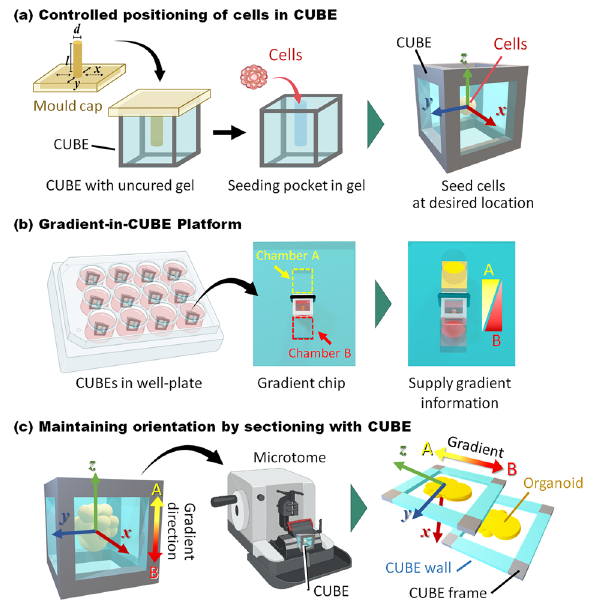
Fig. 1 Work fl ow from gradient culture to sectioning for imaging. The concept for this work was to utilise the CUBE culture device to a fi rstly control the seeding position of cells at the desired location, b then transfer the CUBE to a Gradient-in-CUBE chip to culture cells with a morphogen gradient, and c fi nally section the sample with the CUBE to maintain gradient orientation information in the